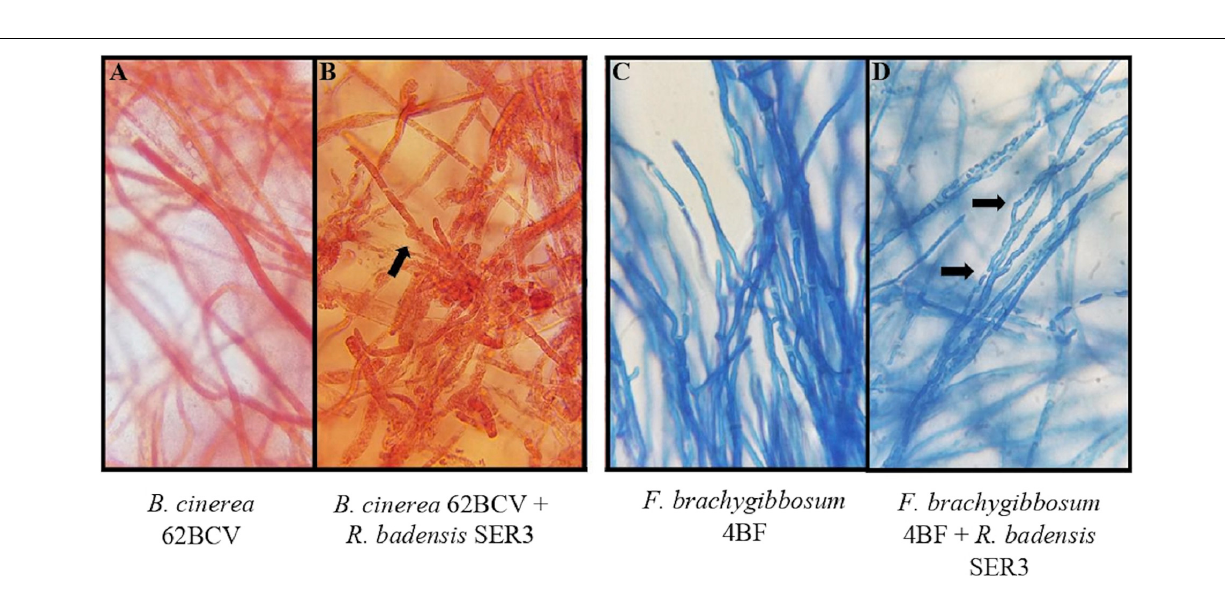
Frontiers in Microbiology |